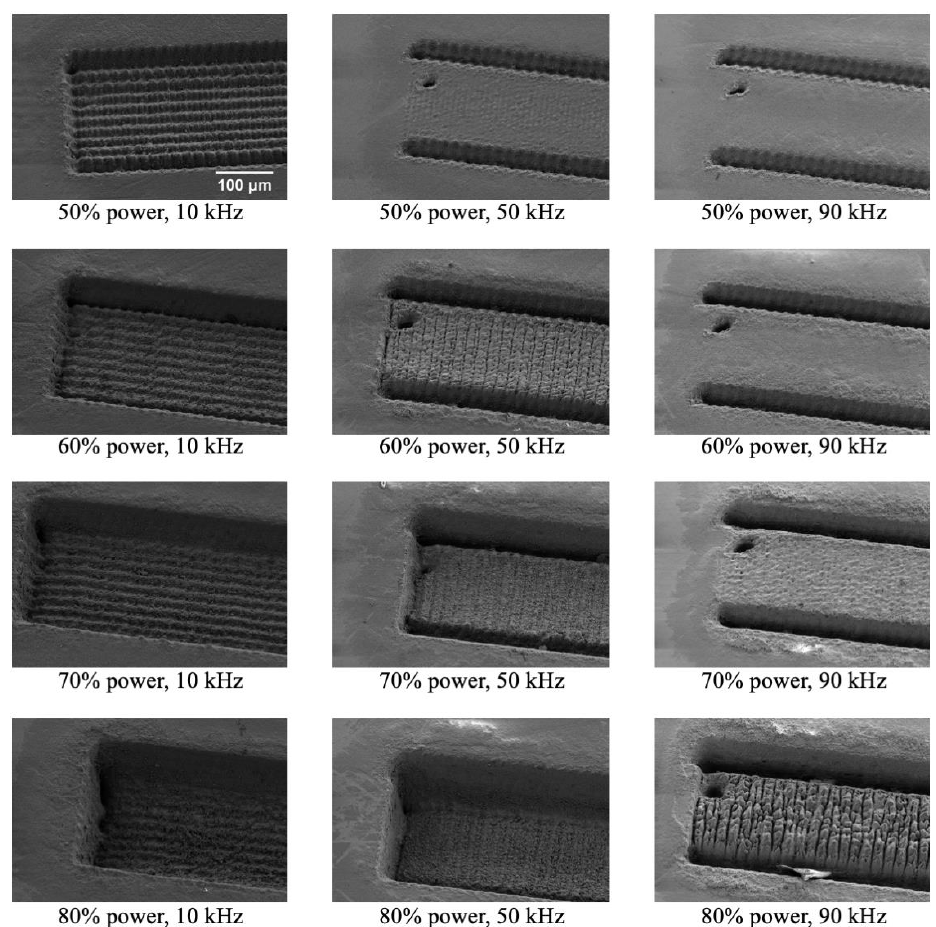
Figure 3. SEM images of structures fabricated at different laser radiation powers and pulse frequencies. In all images the number of passes are 50, and all images are the same scale.